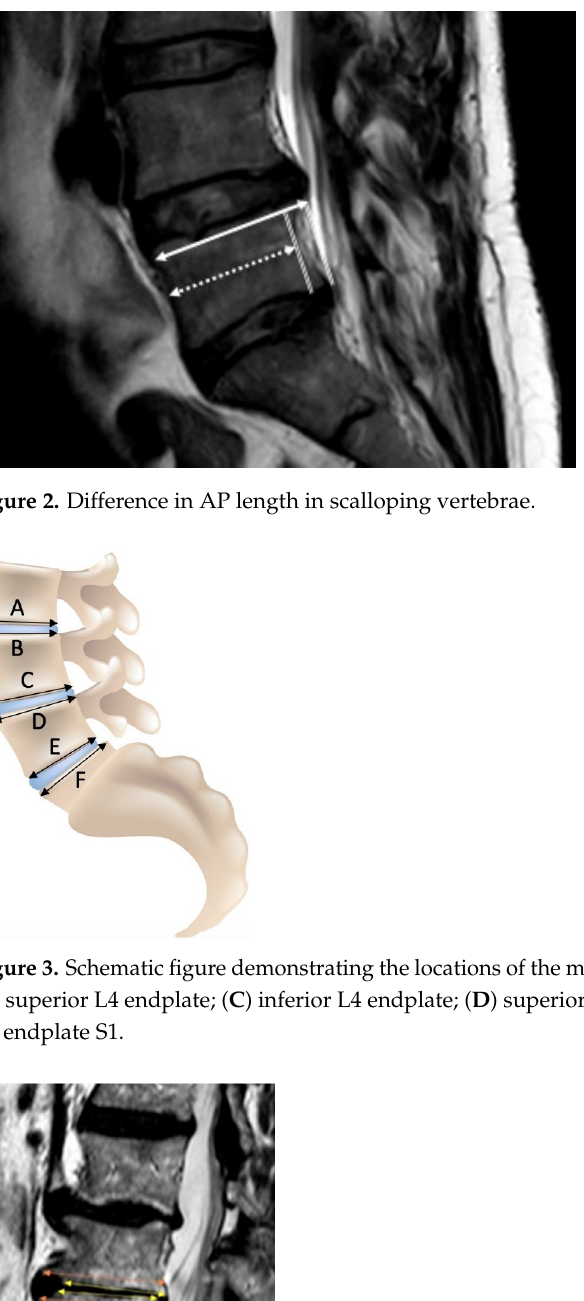
Figure 4. Only the effective bony area (yellow arrows) was measured compared to the maximum length (orange arrows).